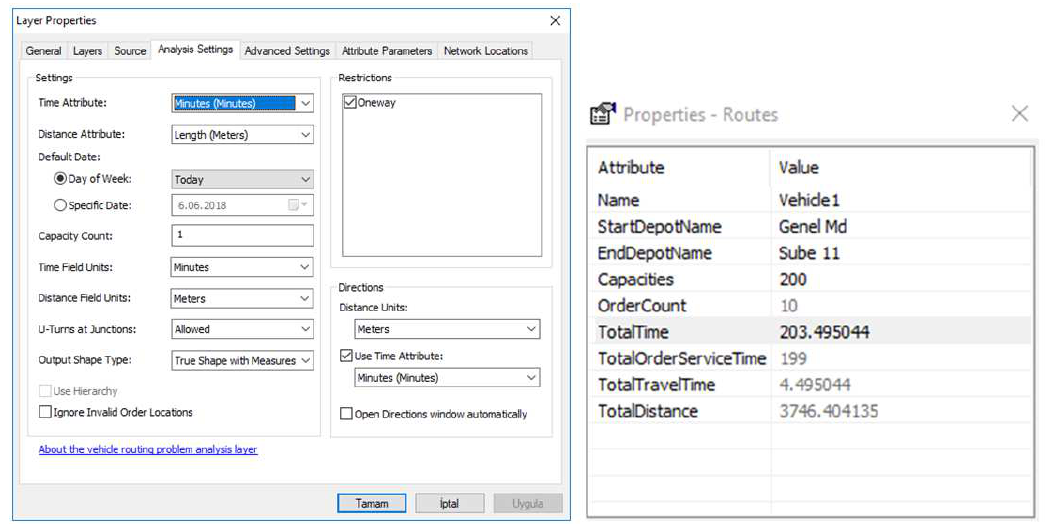
Figure 4. Locations of district office and branches.